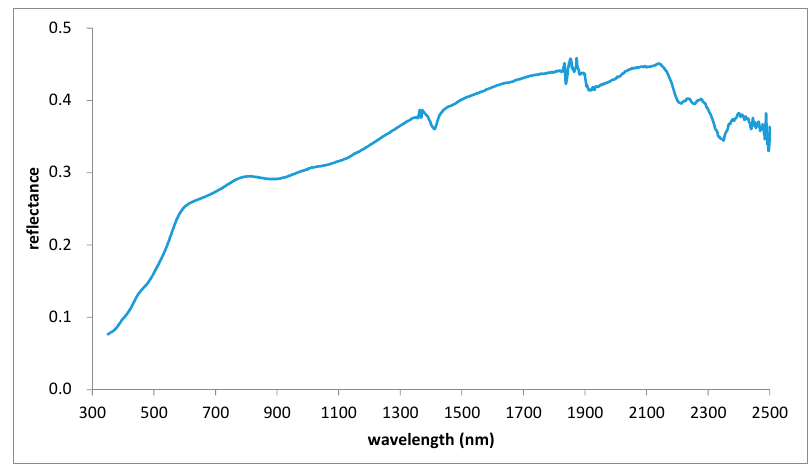
Figure 8. Ground reflectance measured on 7 March 2017 over the desert area south of the Dunhuang calibration site.